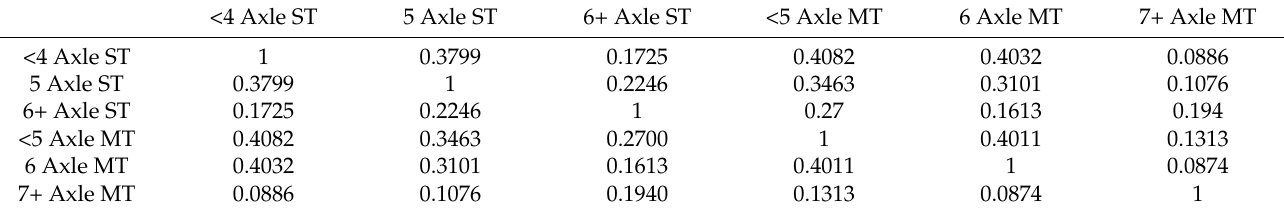
Table 2. Correlation coefficients of heavy vehicle weight.